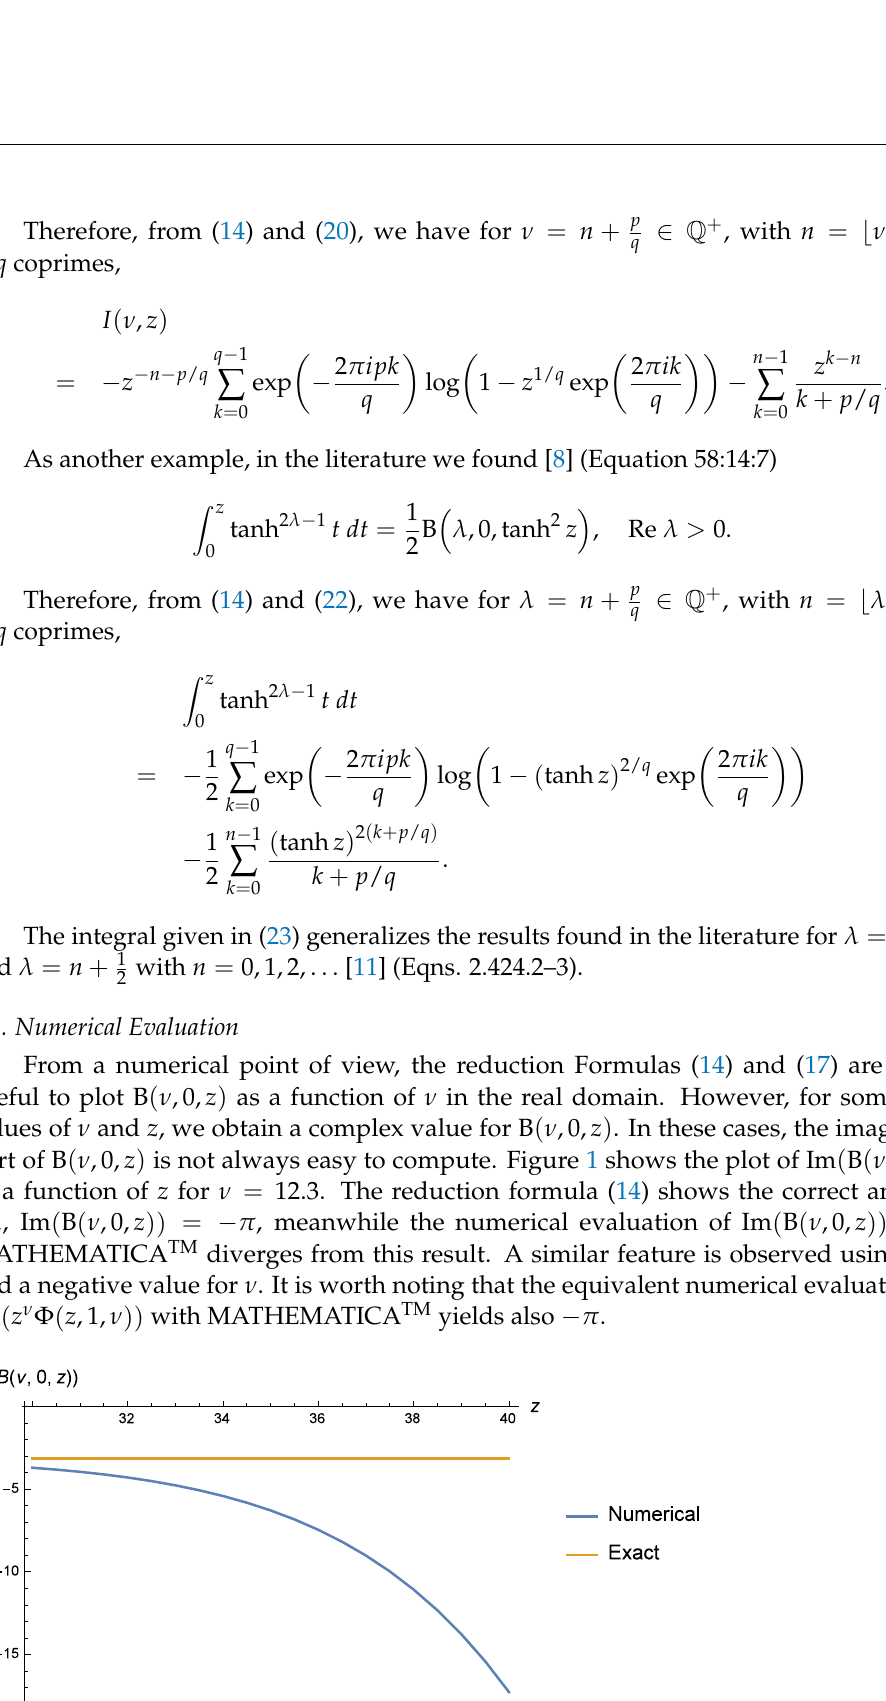
Figure 1. Evaluation of Im ( B ( ν ,0, z )) with MATHEMATICA TM and (14) with ν =